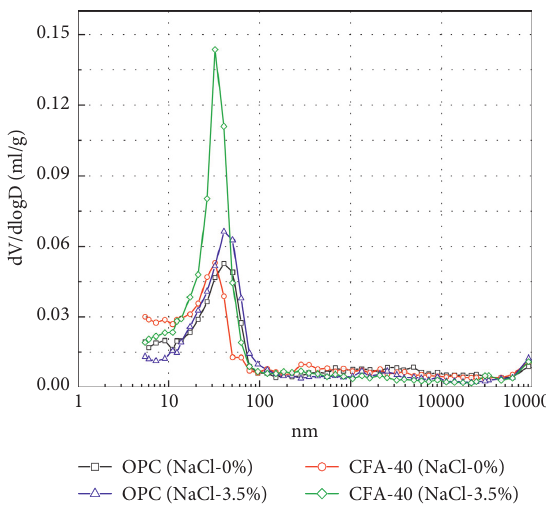
Figure 8: Differential logarithmic curves of Mercury